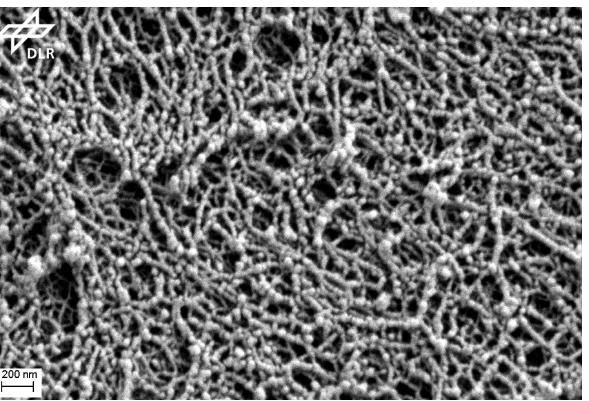
Figure 1. SEM picture of an RF-aerogel with a pearl-necklace microstructure. Picture provided by M. Schwan, DLR.